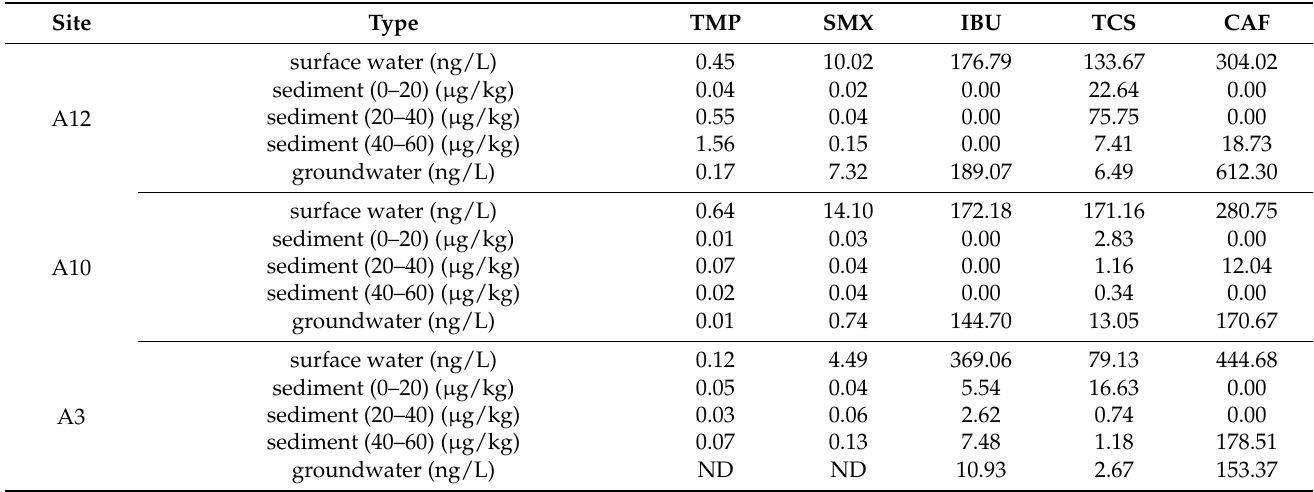
Table 4. Concentrations of PPCPs in three media in typical sections.